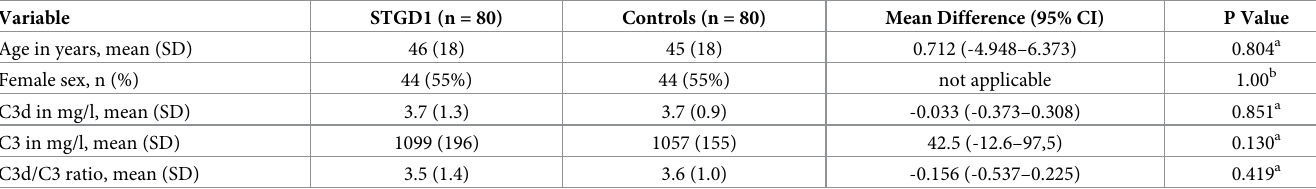
Table 1. Complement activation levels in Stargardt disease patients and controls matched for age and sex.